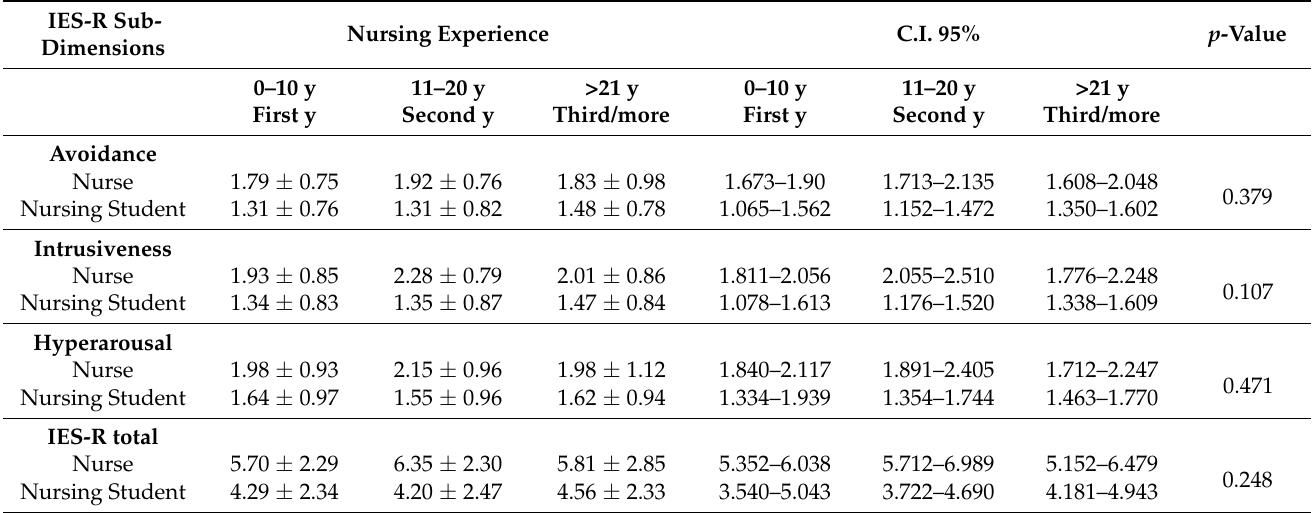
Table 3. IES-R values recorded in Nurses and Nursing Students according to Nursing Experience.